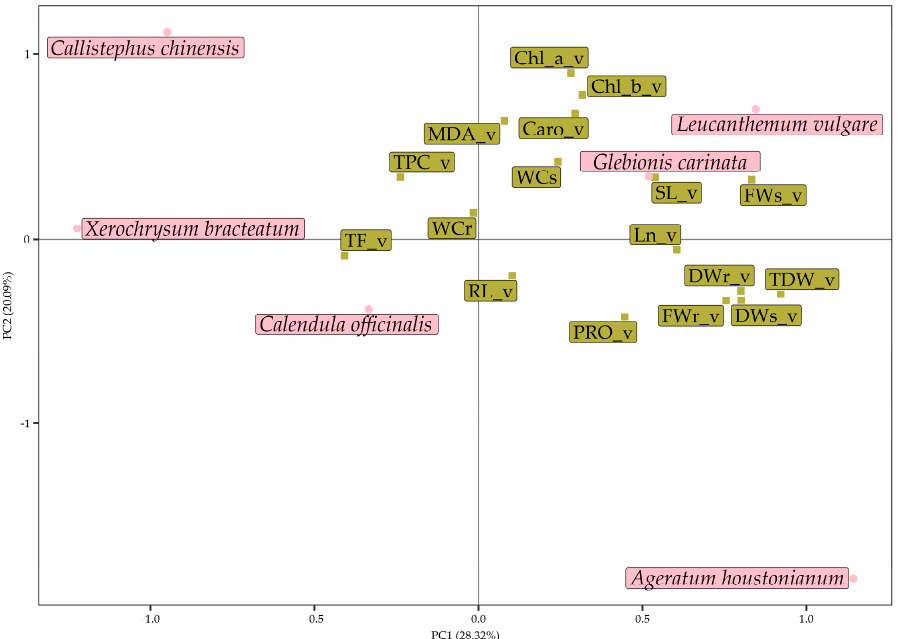
Figure 8. PCAiws biplot. Pink circles indicate the barycentres of the six studied species, whereas the green squares represent the 17 measured traits under intermediate water stress conditions (i.e., no drought stress). Abbreviations: shoot fresh weight (FWs), shoot dry weight (DWs), root fresh weight